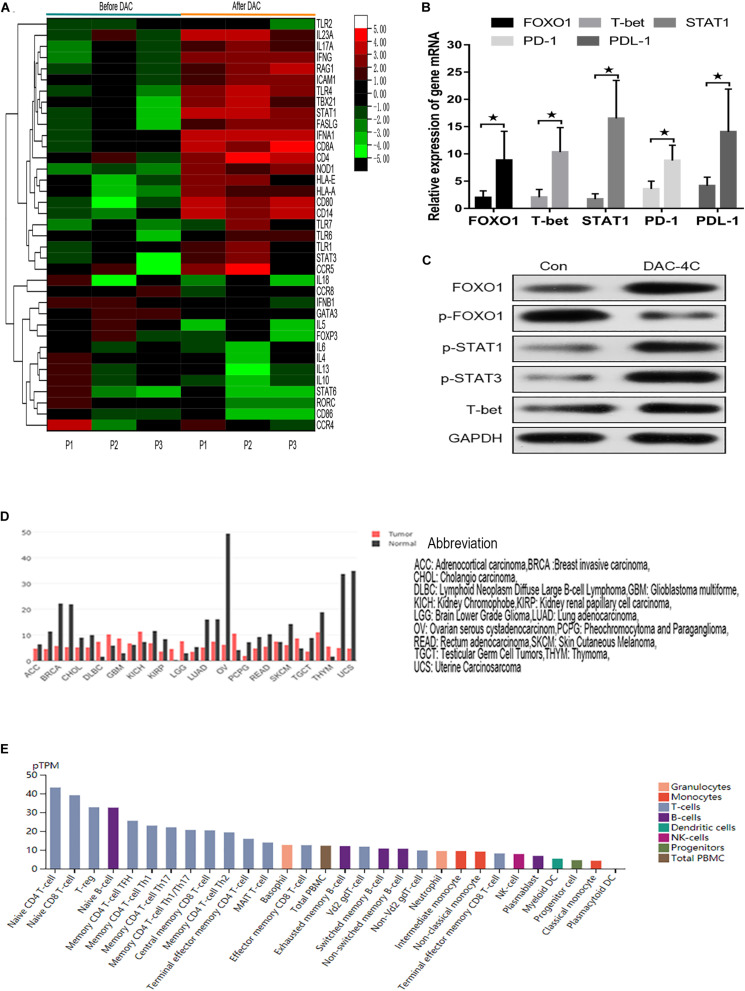
Hierarchical heat map showing the gene DEGs in immune processes after DAC treatment. Normalized log2 transformed values as determined by RT2 Profiler Human Innate and Adaptive Immune Responses PCR Array in T lymphocytes of 3 matched MDS patients collected at non-DAC and 4-course-DAC treatment. Each column represents one MDS patient, each horizontal line refers to one gene. The cutoff value of log fold change as >1.5 or <−1.5 and false discovery rate <0.01 was considered (A). The bar charts showed that expression of FOXO1, T-bet, STAT1, PD-1, PDL-1 increased significantly after DAC treatment (B). Western blot showed that FOXO1, p-STAT1, p-STAT3, and T-bet in one MDS patient increased with p- FOXO1 protein decreasing after DAC treatment (C). Using the GEPIA (Gene Expression Profiling Interactive Analysis) dataset (http://gepia.cancer-pku.cn/), we compared the mRNA expression of FOXO1 between different tumors and normal tissues. The results indicated that the expression levels of FOXO1 were obviously higher in normal tissues than in tumors. The gene expression profile across different tumor samples and paired normal tissues (Bar plot). The height of bar represents the median expression of certain tumor type or normal tissue (D). Utilizing an online tool (The Human Protein Atlas which aim to map all the human proteins in cells, tissues and organs using integration of various omics technologies, https://www.proteinatlas.org/), we explored the mRNA expression of FOXO1 in immune cells. The results show FOXO1 plays an important role in immune cell development (E). * means P < 0.05.